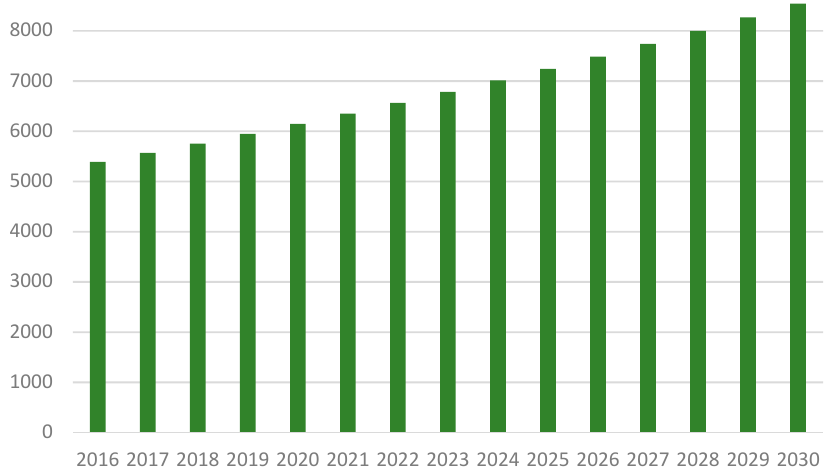
Figure 7. Household growth (Thousands of households per year).